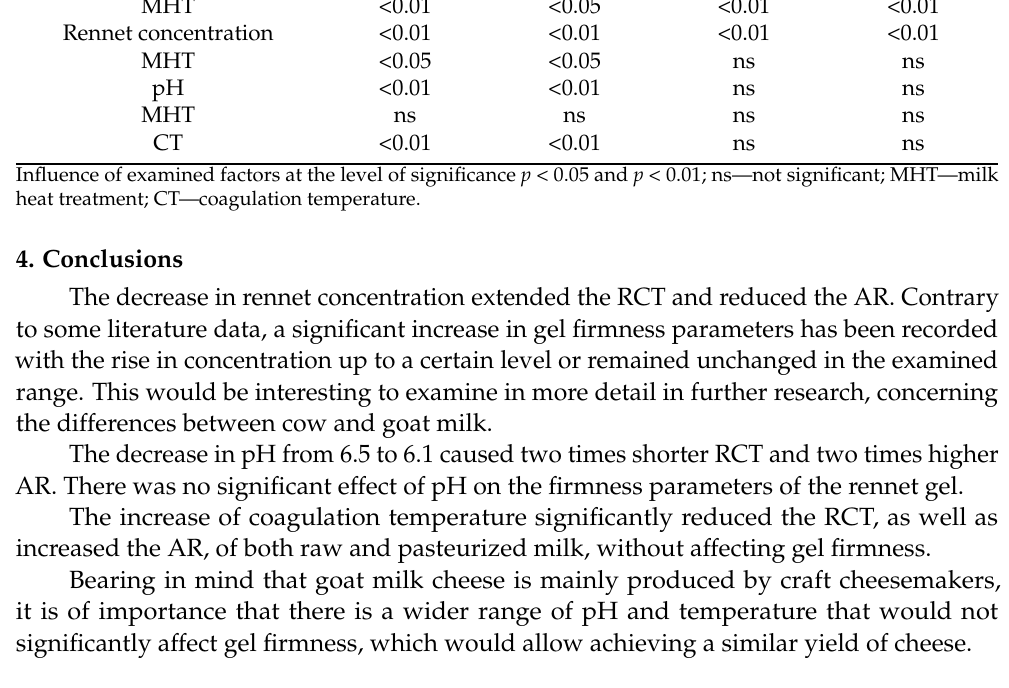
Table 1. Influence of individual factors on measured parameters for each set of experiments. RCT